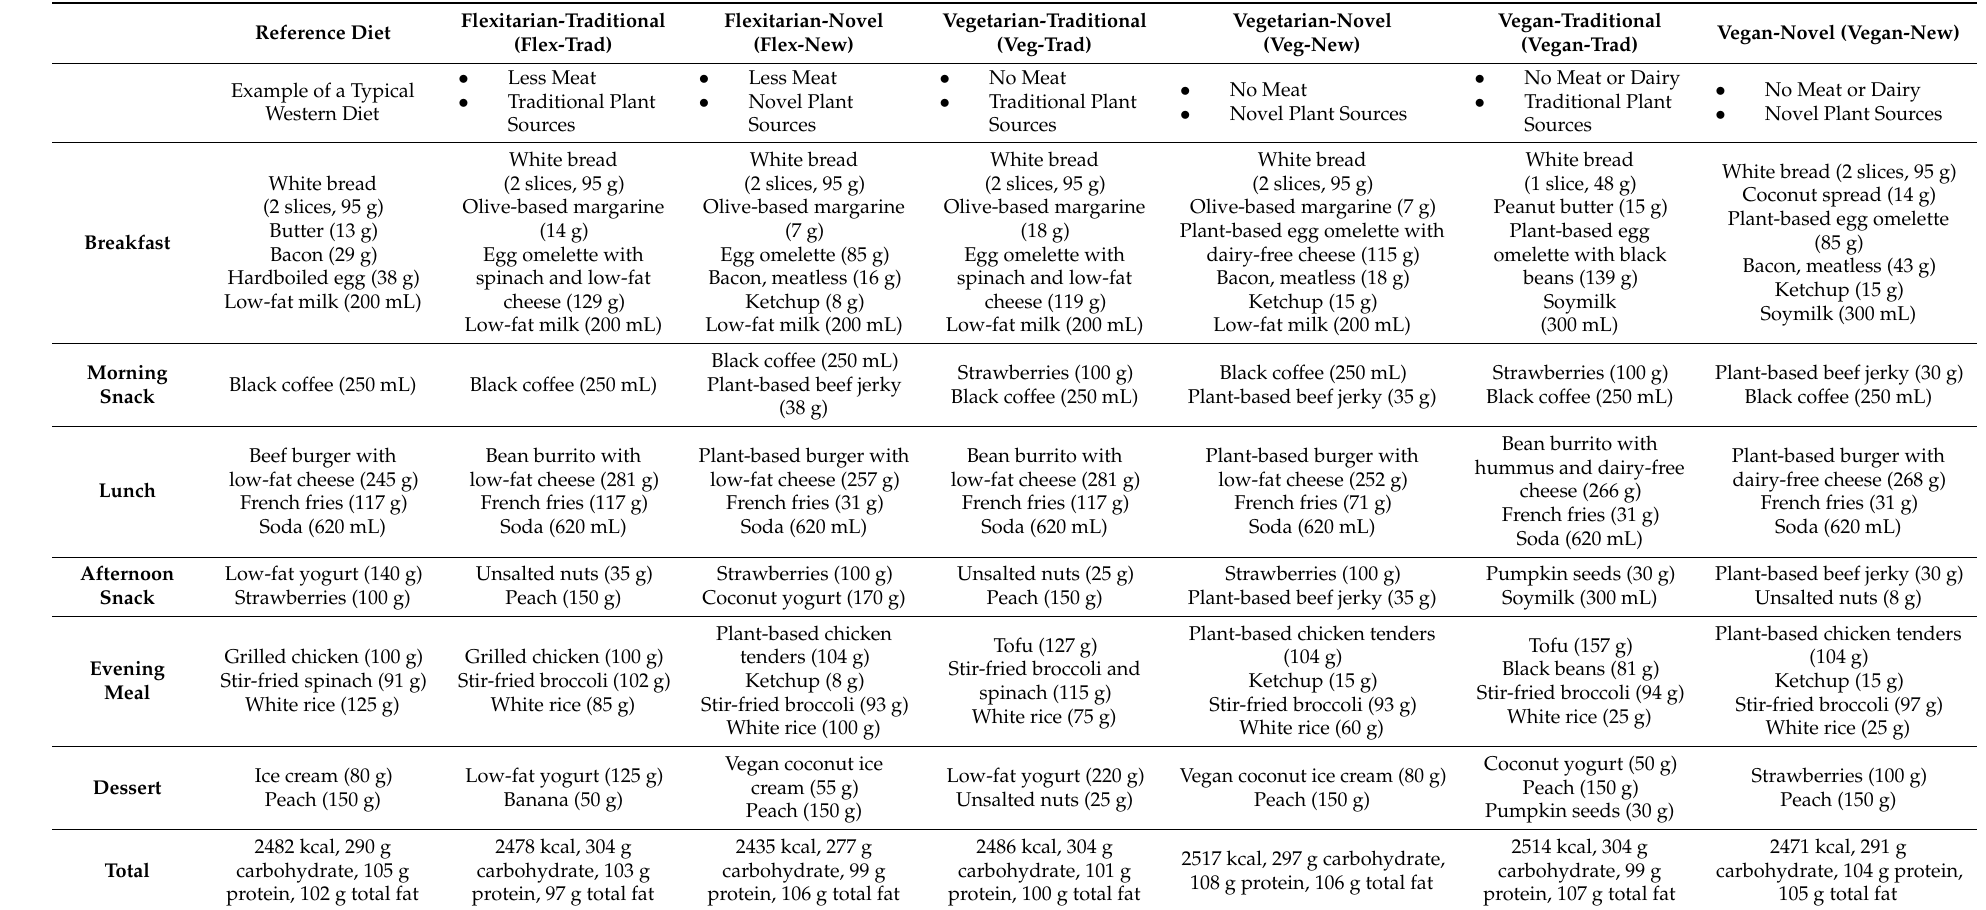
Values for mixed foods such as omelettes, burgers, burritos and stir-fried vegetables differ across diets due to varying amounts of individual ingredients such as oil, salt and cheese. Nutrient values for each food item are taken from the United States Department of Agriculture [38]; Health Promotion Board, Singapore [39]; and Internet sources [11,40–42]. These diets used unfortified products and assumed no multivitamins nor supplements were